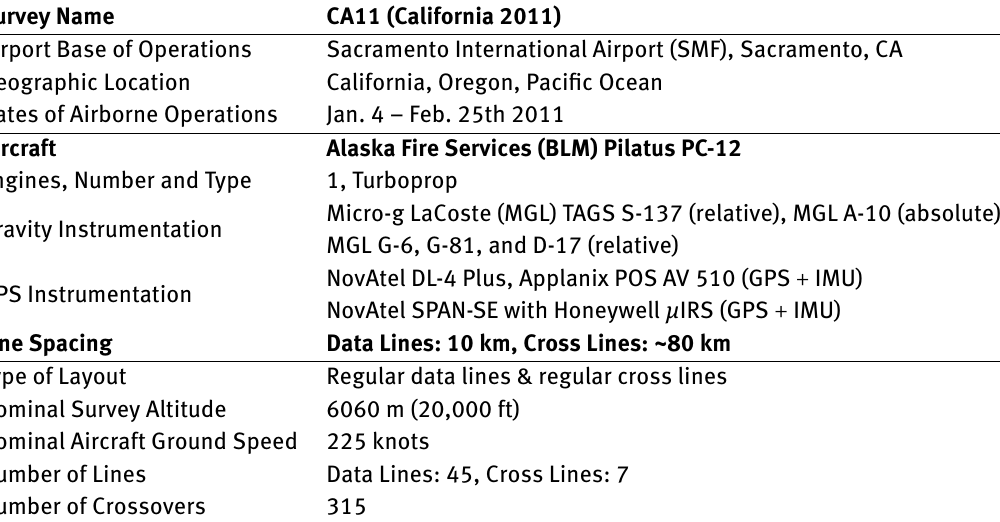
Table 4: Synopsis of survey layout and execution for California test area